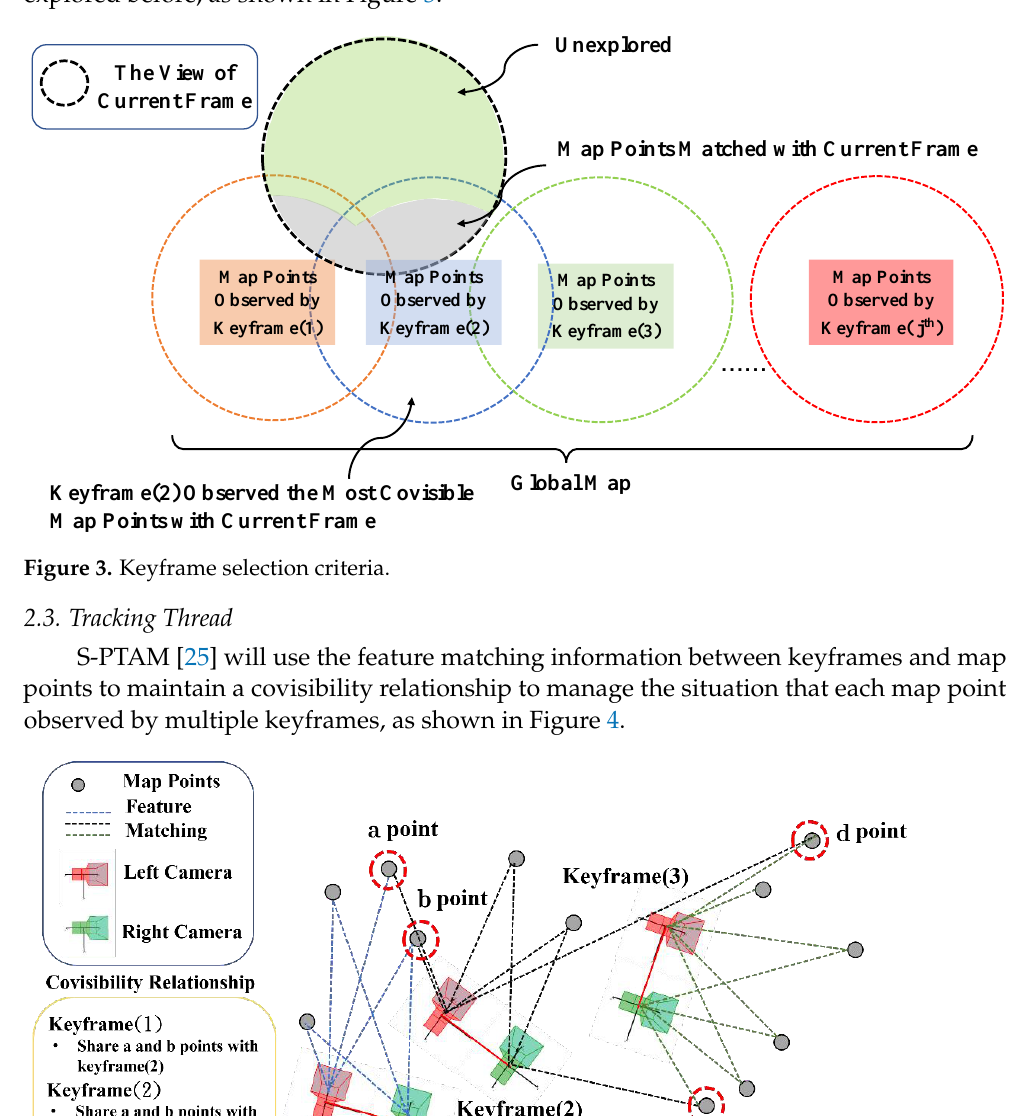
Figure 2. Illustration of navigation frame.